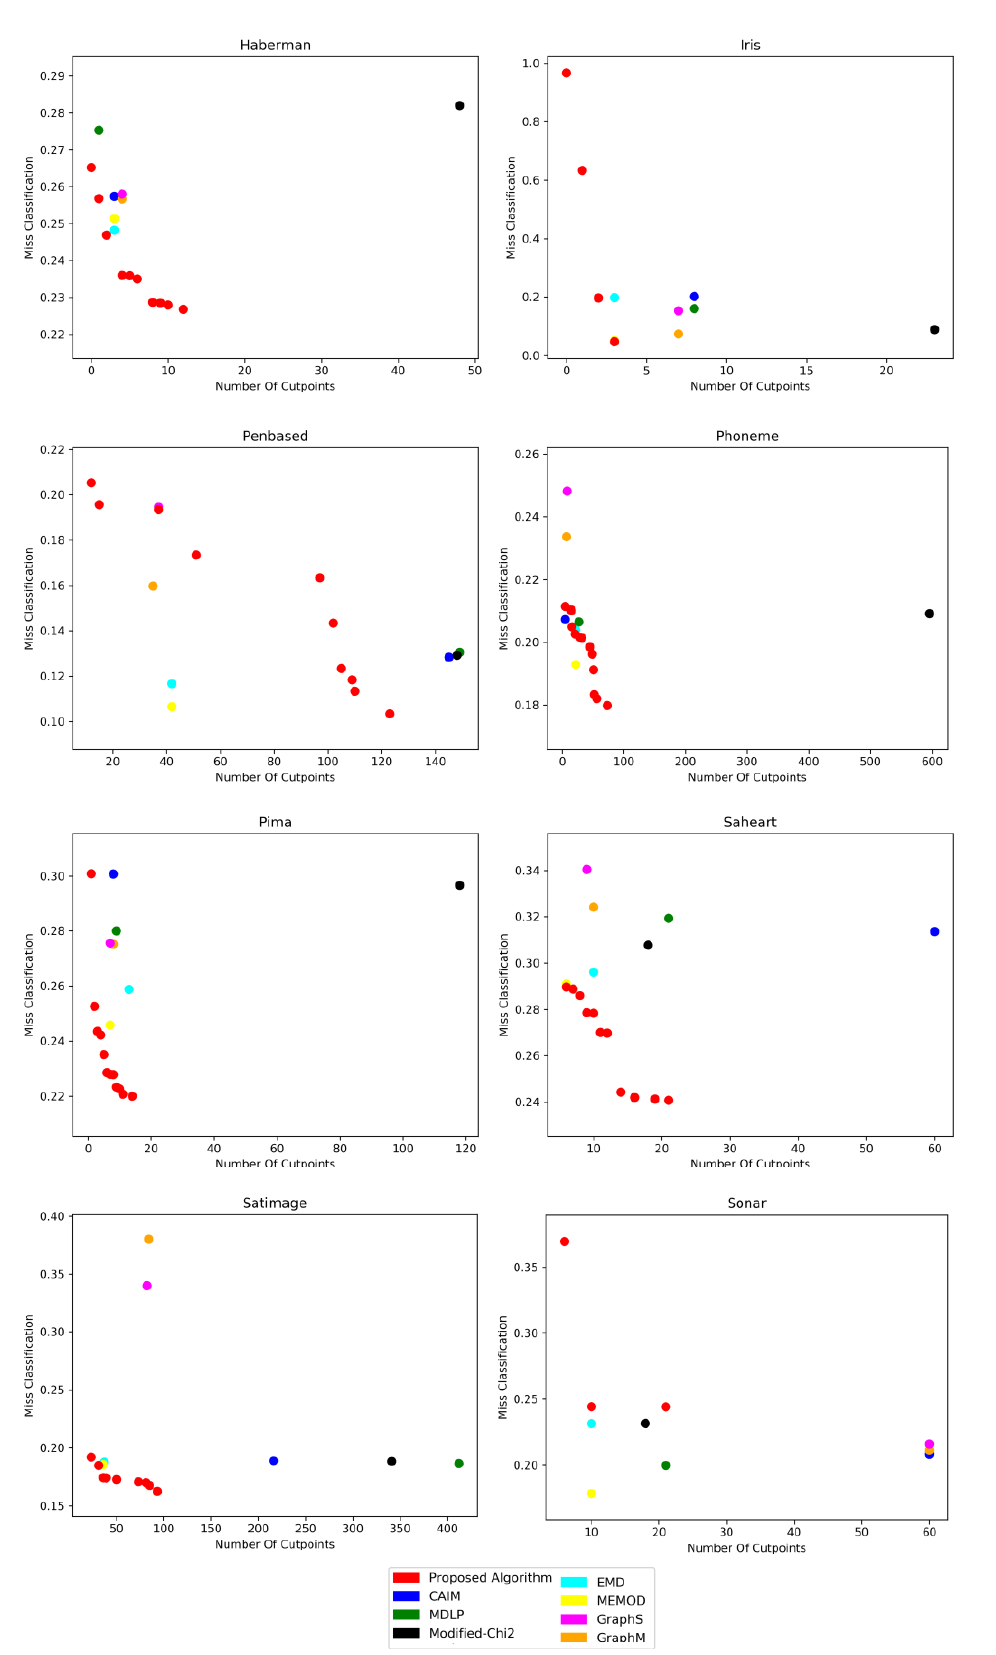
Figure 2. Projection of non-dominated solutions obtained by the proposed algorithm for the considered datasets